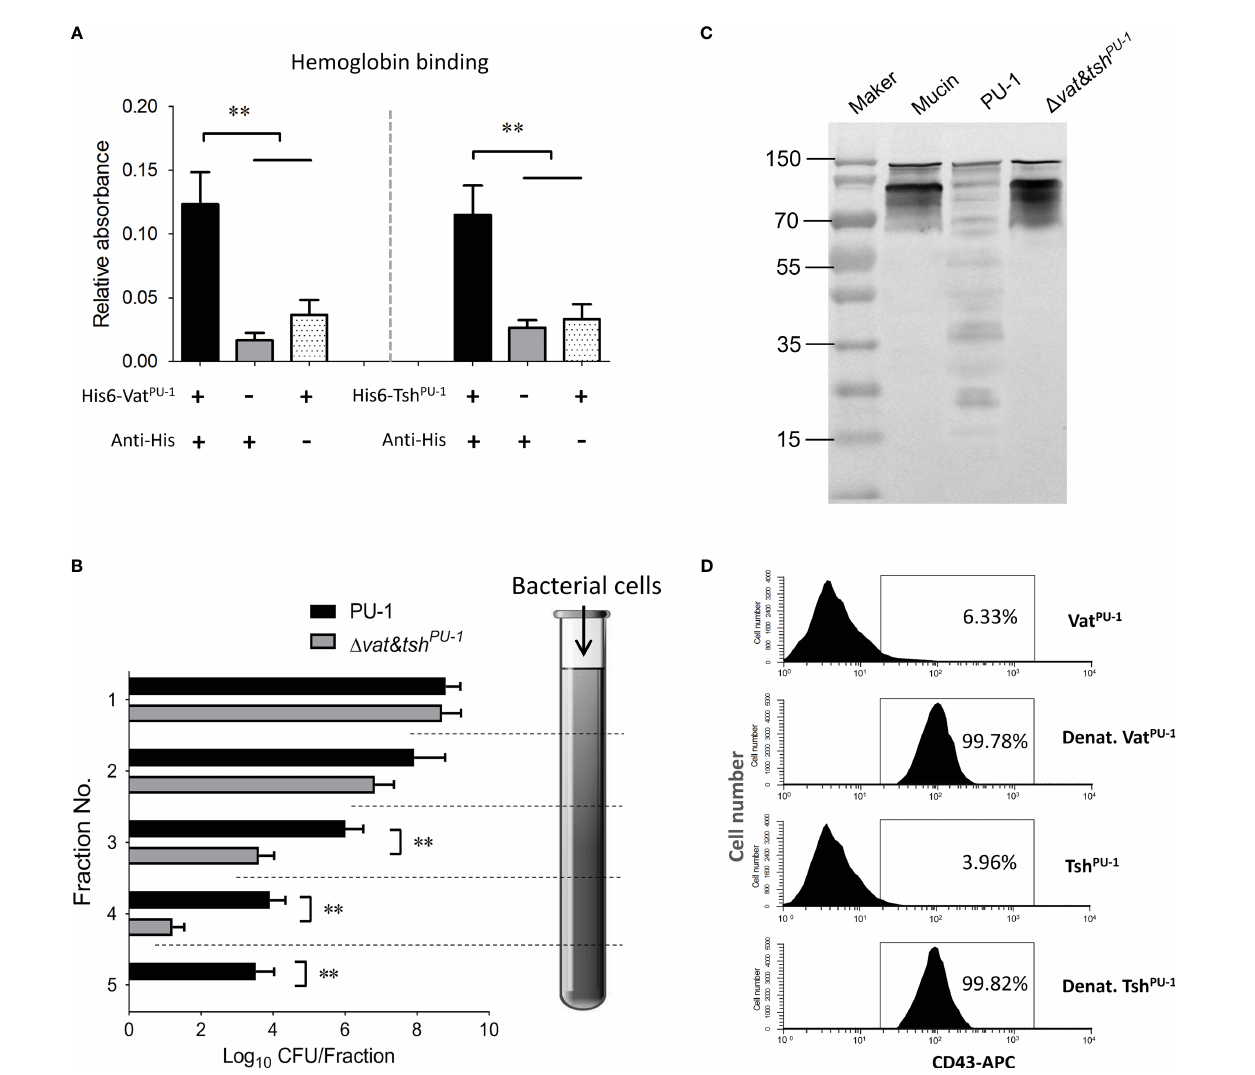
FIGURE 4 Vat PU-1 and Tsh PU-1 bound to and cleaved diverse O-glycosylated mucin-like proteins. (A) SPATEs bind to the hemoglobin. Human hemoglobin was coated onto a 96-well microplate and incubated with the puri fi ed proteins. Binding was detected by an indirect ELISA. (B) The assessment of mucin degradation by using a column penetration assay. Quanti fi cation of indicated ExPEC strains in fractions eluted from columns fi lled with gel-forming mucus (1 to 5 fractions: top to bottom of the column). (C) Mucin extracted from porcine respiratory tract was incubated overnight with fi ltered culture supernatants of indicated ExPEC strains. Mucin degradation was observed by Western blot using an anti-MUC2 antibody. (D) The degradation mediated by Vat PU-1 and Tsh PU-1 to the extracellular domain of O-glycosylated mucin-like protein CD43 on human leukocytes. The PMNs were isolated from human blood and incubated with the puri fi ed Vat PU-1 , Tsh PU-1 , or denatured proteins at 37°C for 30 min. Flow cytometry was employed to analyze these samples using monoclonal antibodies against the extracellular domains of CD43. Flow cytometry data are representative of at least three independent experiments. ** P value < 0.05, which is considered statistically signi fi